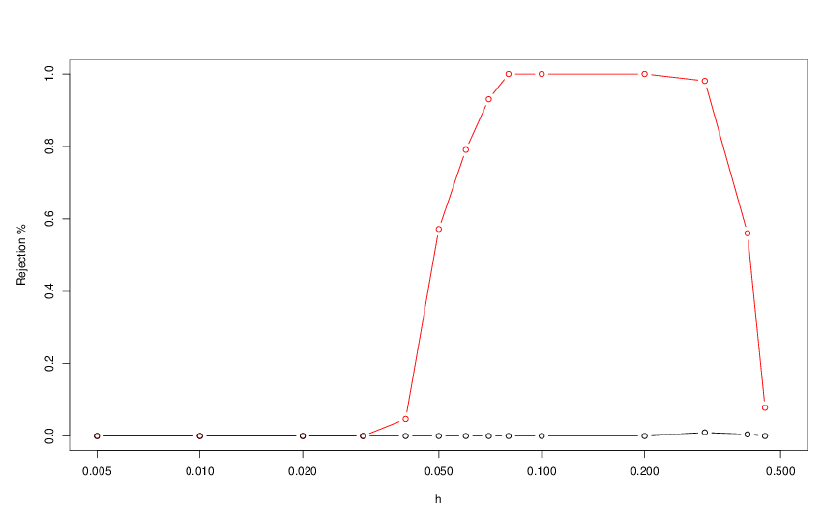
(8) with m = 20 as a function of h . The red (resp. black) line corresponds CvM , n